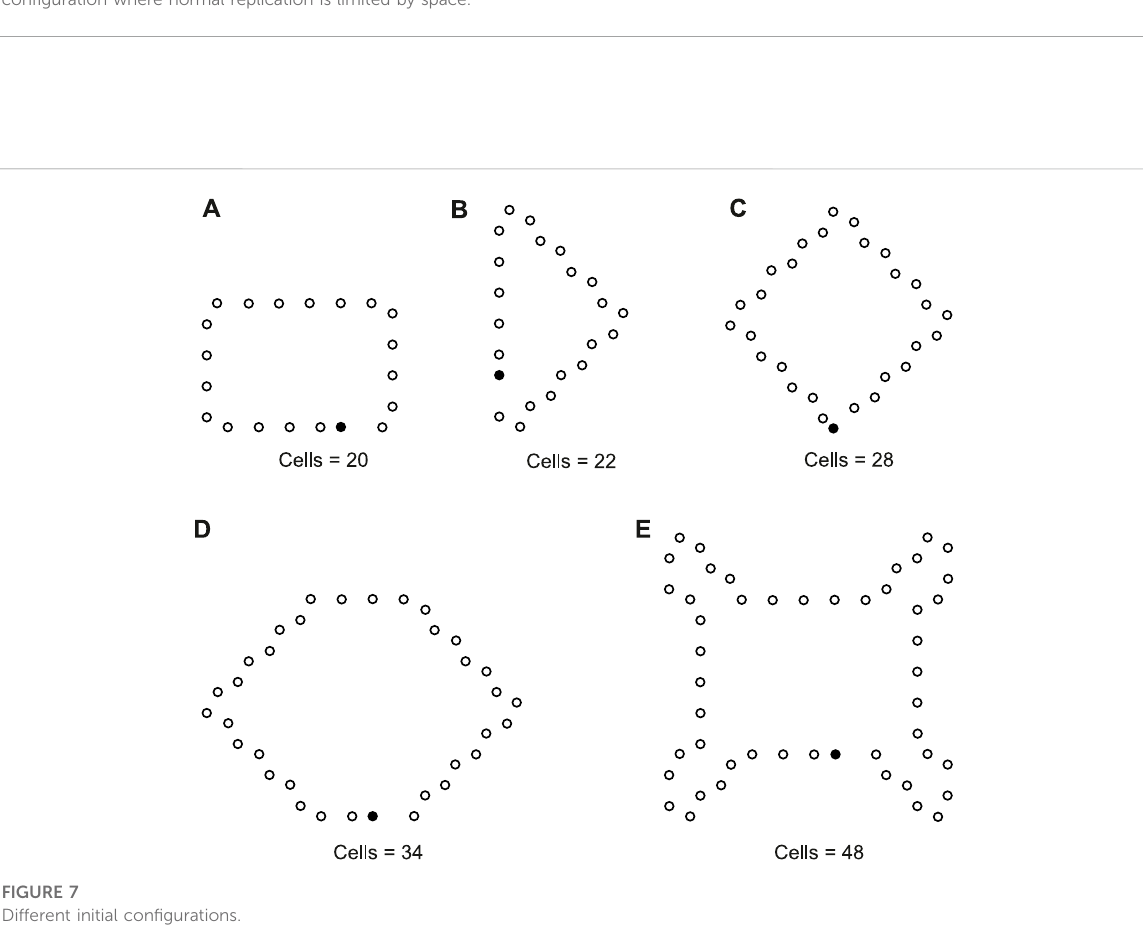
FIGURE 6 The different results of the greedy selection mechanism, adding mechanism, and changing mechanism starting from the same initial con fi guration where normal replication is limited by space.